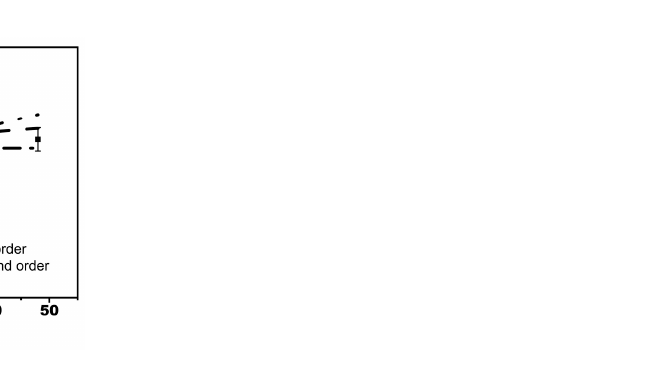
(13) q (cid:2930) = (cid:2921) (cid:3118) (cid:2927) (cid:3163)(cid:3118) (cid:2930) (cid:2869)(cid:2878)(cid:2921) (cid:3118) (cid:2927) (cid:3163) (cid:2930) Pseudo second order